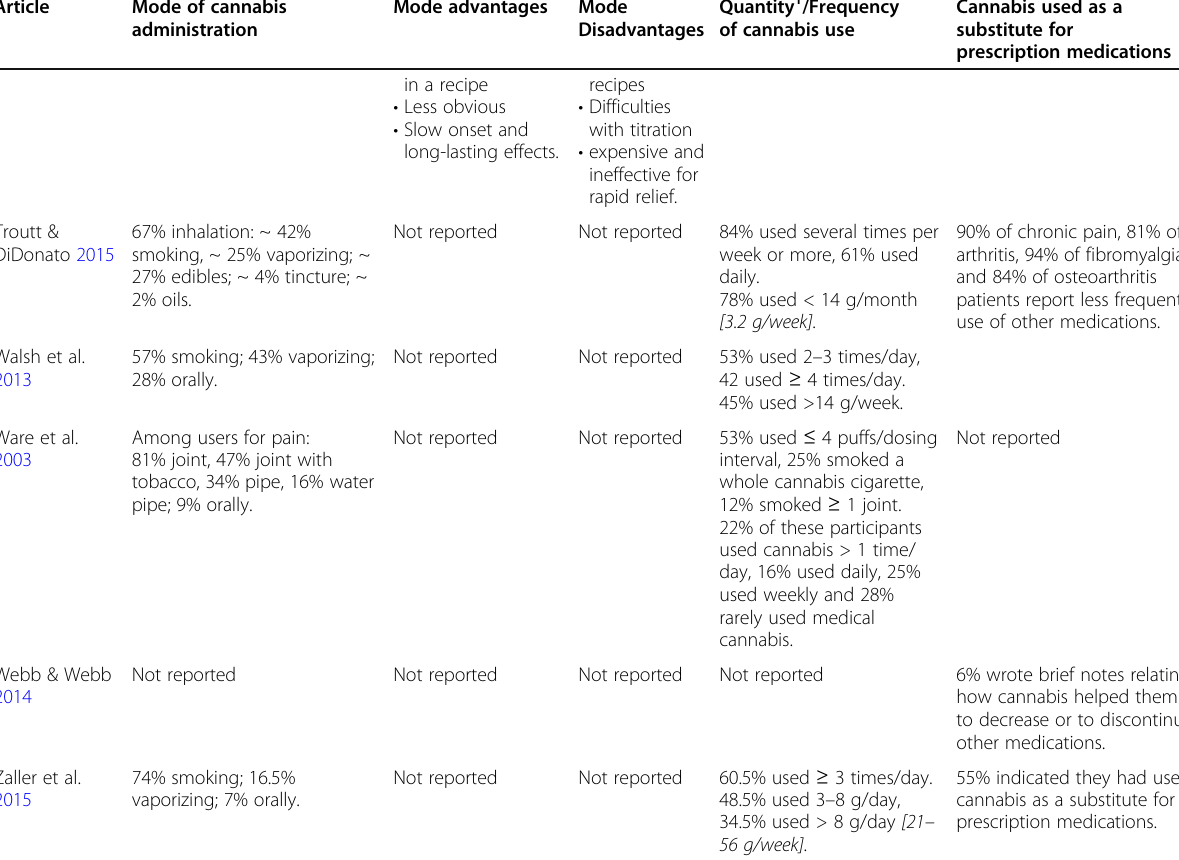
Table 2 Patterns of medical cannabis use and utilization of medical cannabis as a substitute for prescription medications